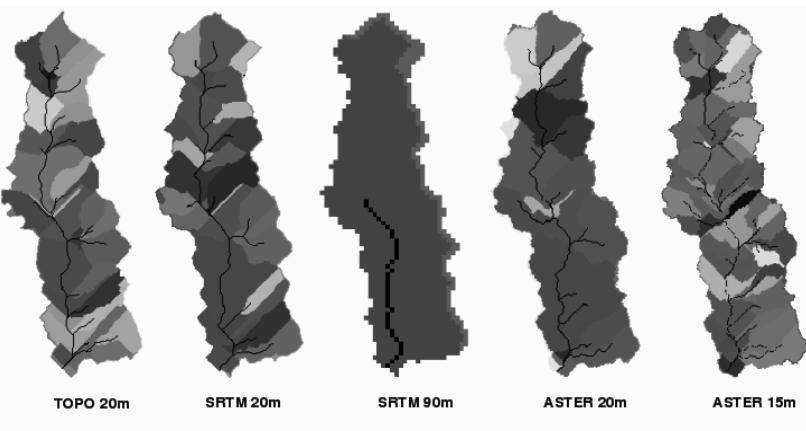
Figure 2. Watershed basins and stream channels represented by the DEMs at original and interpolated resolutions.